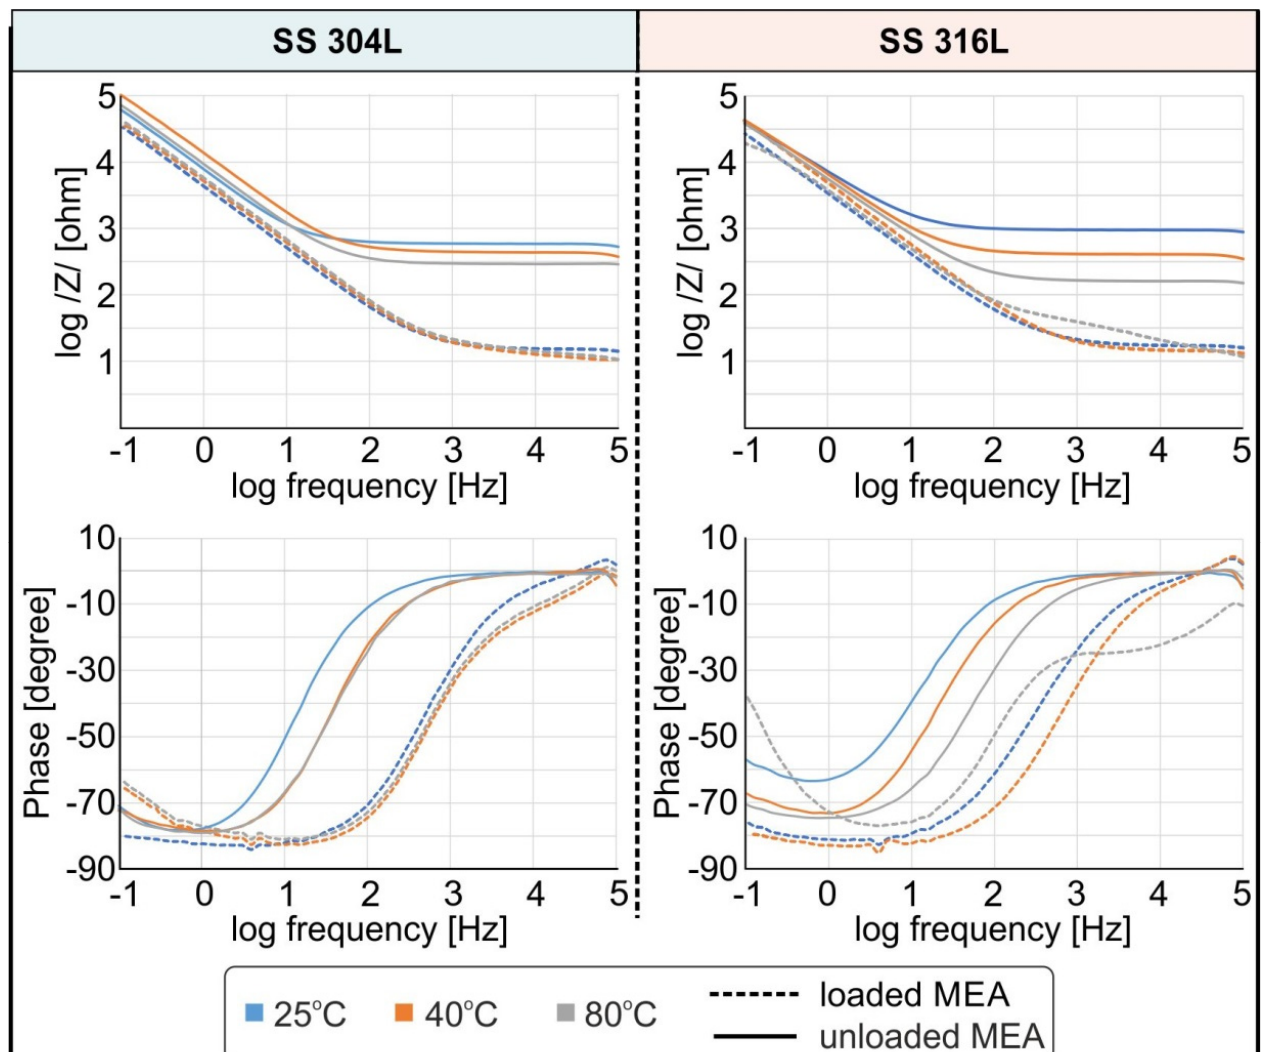
Figure 6. Nyquist plots for SS304 and SS316L at 25 °C, 40 °C and 80 °C when immersed in unloaded and loaded MEA solution.